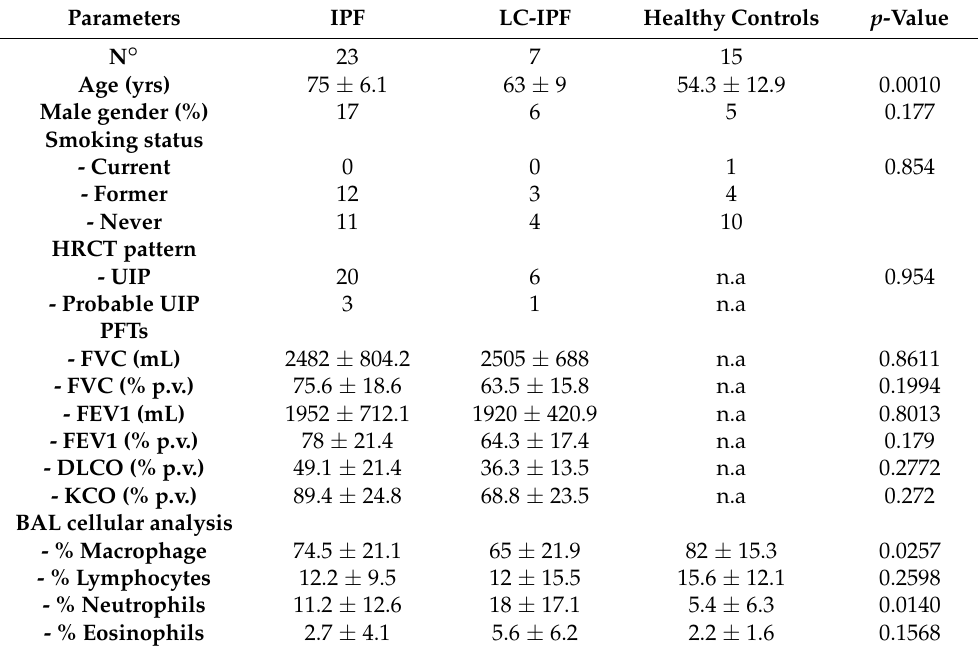
Table 1. Demographic features, radiological data, respiratory functional parameters, and BAL cellular analysis among IPF, LC-IPF and healthy subjects. FVC: forced vital capacity; FEV1: forced expiratory volume in the first second; DLCO: diffusion lung capacity for carbon monoxide; KCO: approximately kCO/barometric pressure in mL/minute/mmHg/L; HRCT: high resolution computed tomography; PFT: pulmonary function